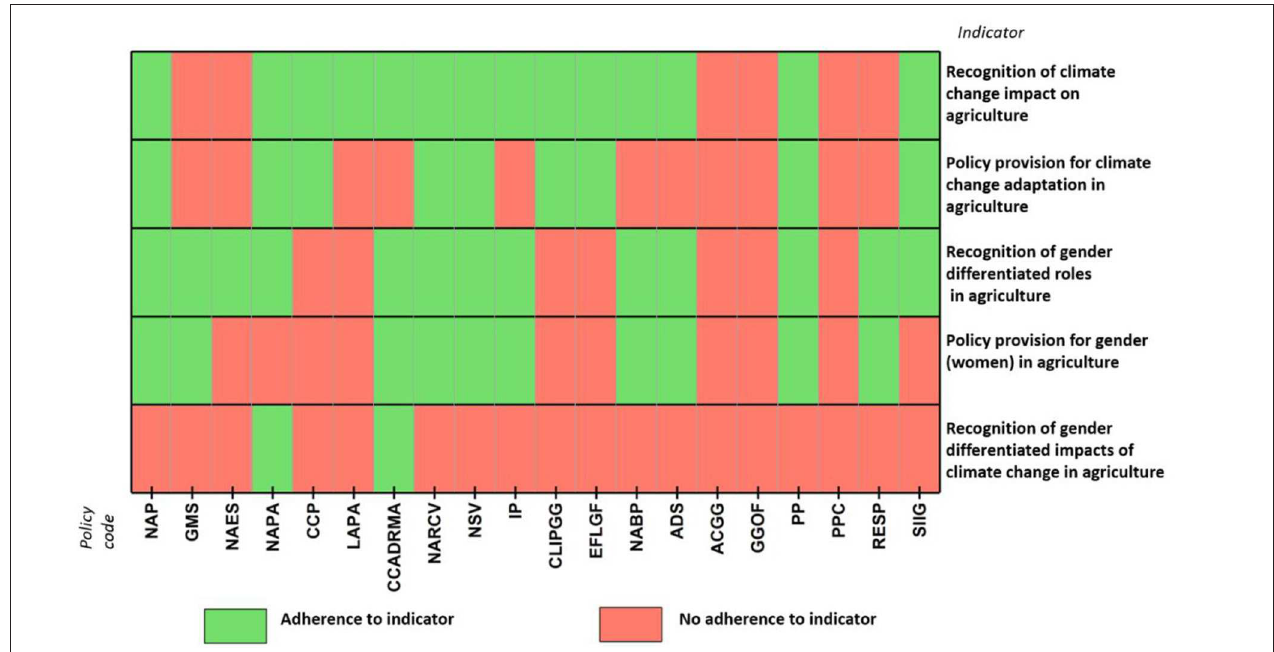
FIGURE 3 | Analysis of key climate change and agricultural policies and strategies based on five indicators. NAP, National Agriculture Policy 2004; GMS, Gender Mainstreaming Strategy 2006; NAES, Nepa1 Agriculture Extension Strategy 2007; NAPA, National Adaptation Program of Action to Climate Change 2010; CCP, Climate Change Policy 2011; LAPA, National Framework on Local Adaptation Plans for Action 2011; CCADRMA, Ciimate Change Adaptation and Disaster Risk Management in Agriculture: Priority framework for action 2011–2020; NARCV, National Agricultural Research Centre (NARC) Vision; NSV, National Seed Vision 2013–2025; IP, Irigation Policy (revised) 2013; CLIPGG, Crop and Livestock Insurance Premium Grant Guideline 2013; EFLGF, Environment Friendly Local Government Framework 2013; NABP, National Agro Biodiversity Policy 2006 (revised 2014); ADS, Agriculture Development Strategy ADS 2015–2035;